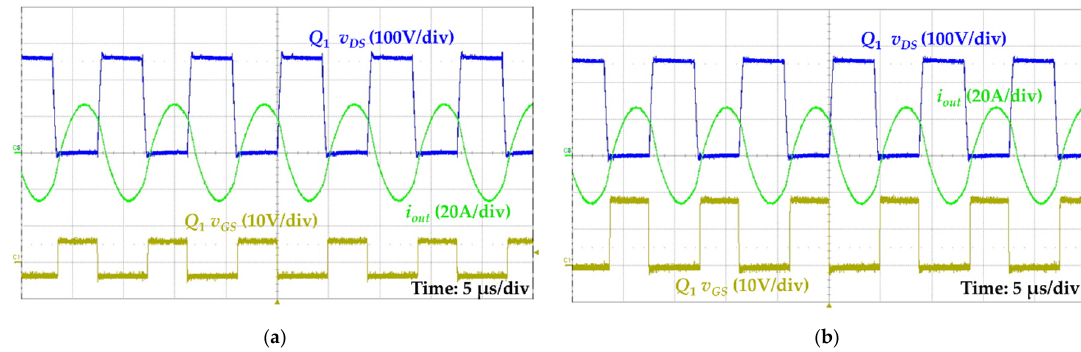
Figure 9. Experimental waveform at 2 kW: ( a ) GaN HEMT; ( b ) SiC MOSFET.